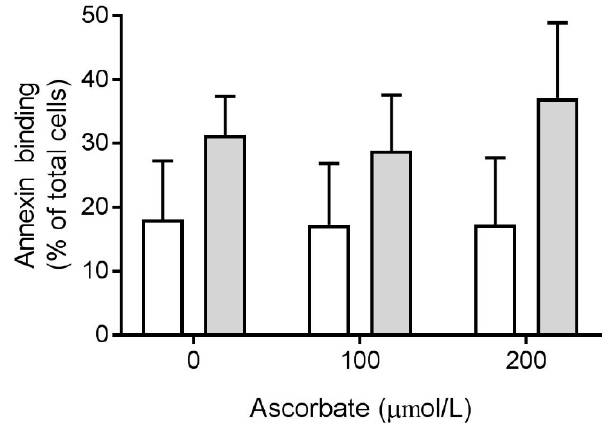
Figure 6. Effect of ascorbate on phosphatidylserine exposure of activated neutrophils. Cells were incubated with extracellular ascorbate (0, 100 or 200 µmol/L) and stimulated with PMA (100 ng/mL) for 2 h (white bars) or 4 h (grey bars). Phosphatidylserine exposure was measured by flow cytometry with Annexin-V FITC. Data represent mean ± SEM, n = 5.